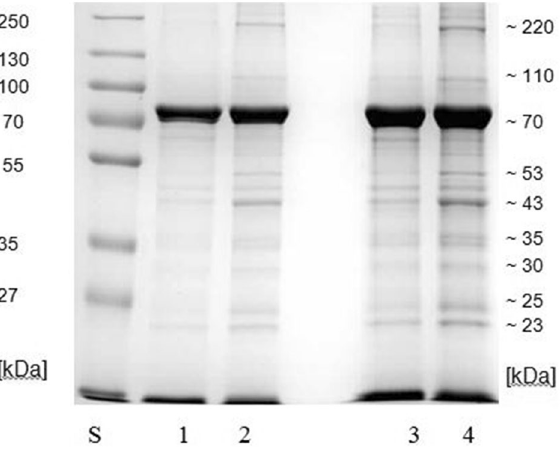
Figure 1. Electrophoretic separation of the proteins of G. intestinalis antigen with SDS-PAGE method (all antigens presented on one blot). S—(molecular weight standard). 1—antigen obtained from the anterior part of the 3 L2 G. intestinalis larva. 2—antigen obtained from the entire L2 G. intestinalis larva. 3—antigen obtained from the anterior part of the 3 L3 G. intestinalis larva. 4—antigen obtained from the entire L3 G. intestinalis larva. (The raw version of blot is available in the Supplementary materials